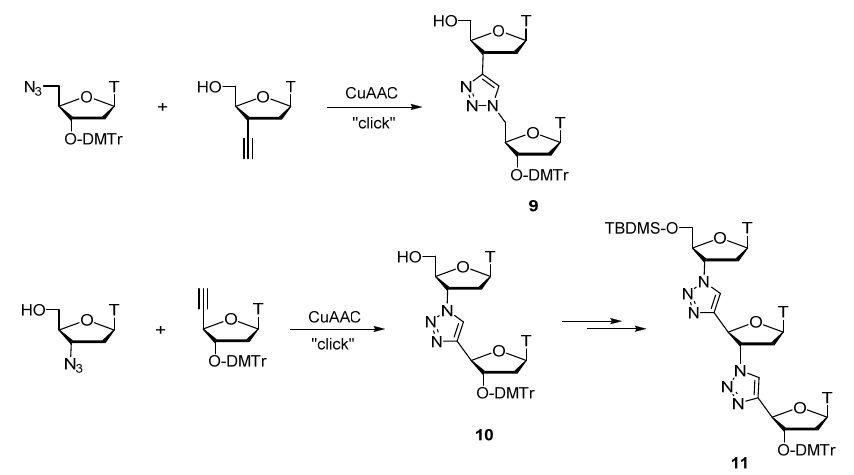
Scheme 2. Synthesis of non-natural dinucleotides and trinucleotide.